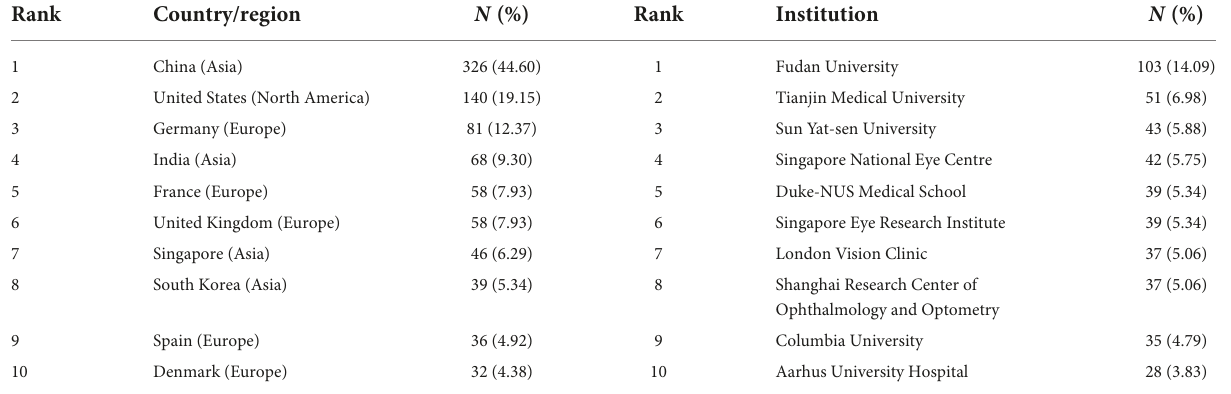
TABLE 1 The top 10 most productive countries/regions and institution for SMILE research. Rank